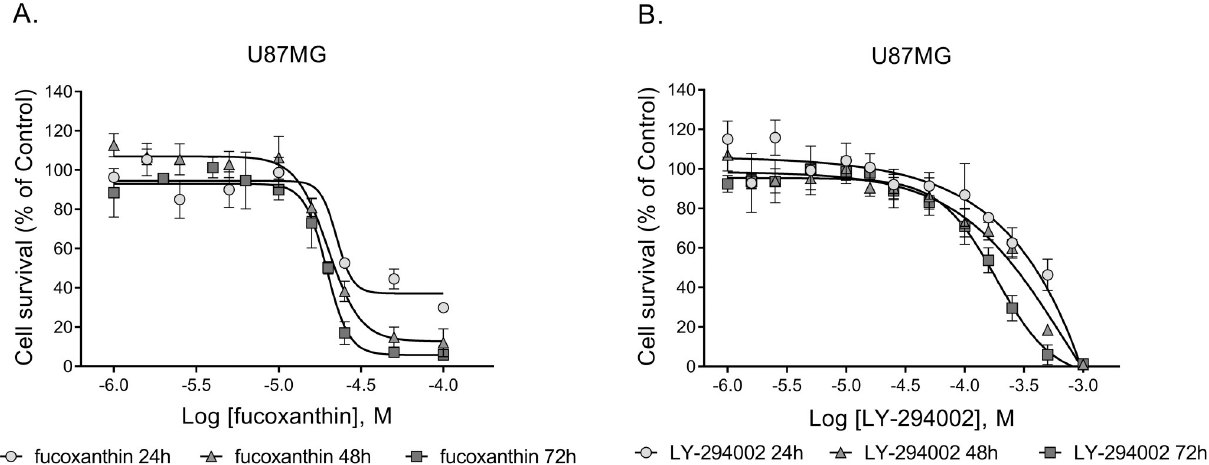
Fig 2. Dose-response relationships of the inhibitory action of fucoxanthin (A) and LY-294002 (B) on U87MG glioblastoma cell survival over 24, 48, or 72h of treatment. Data were normalized relative to the viability of cells treated with vehicle.